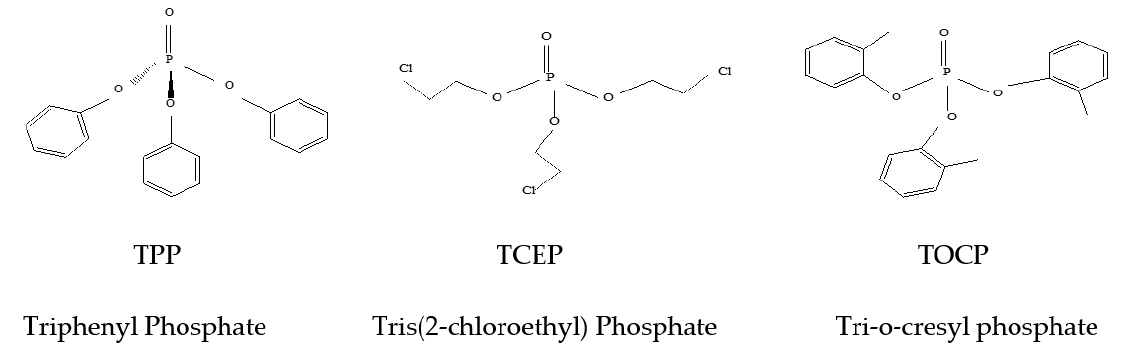
Figure 1. Typical examples of some major molecular structures of OPFRs [2].